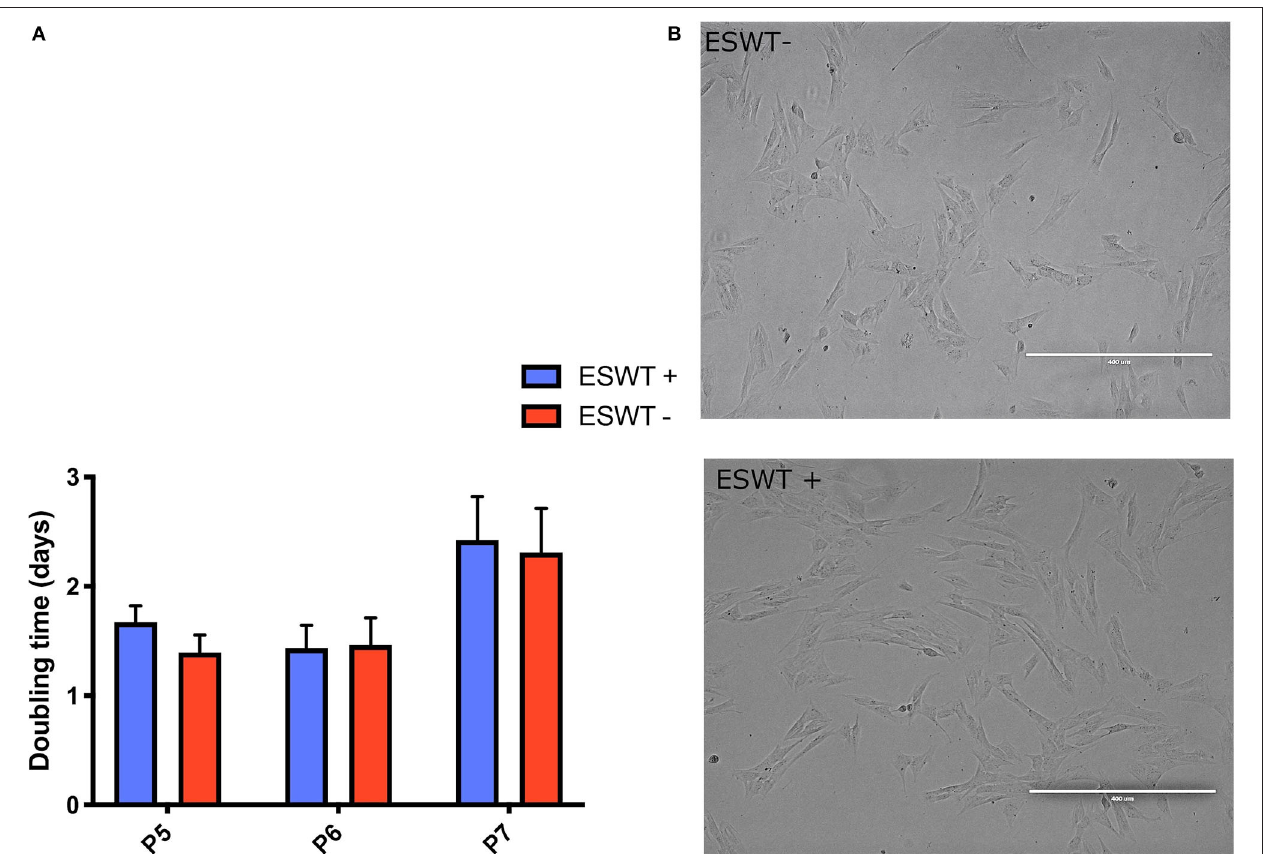
FIGURE 3 | Proliferation. (A) Population doubling times (days) for treated (ESWT + ) and untreated (ESWT–) equine CB-MSCs for passage 5 (P5), 6 (P6), and 7 (P7). Results are shown as mean and CI 95% ( p > 0.05). No differences were observed. (B) There were no obvious morphological differences between the treated (ESWT + ) and untreated (ESWT–) equine